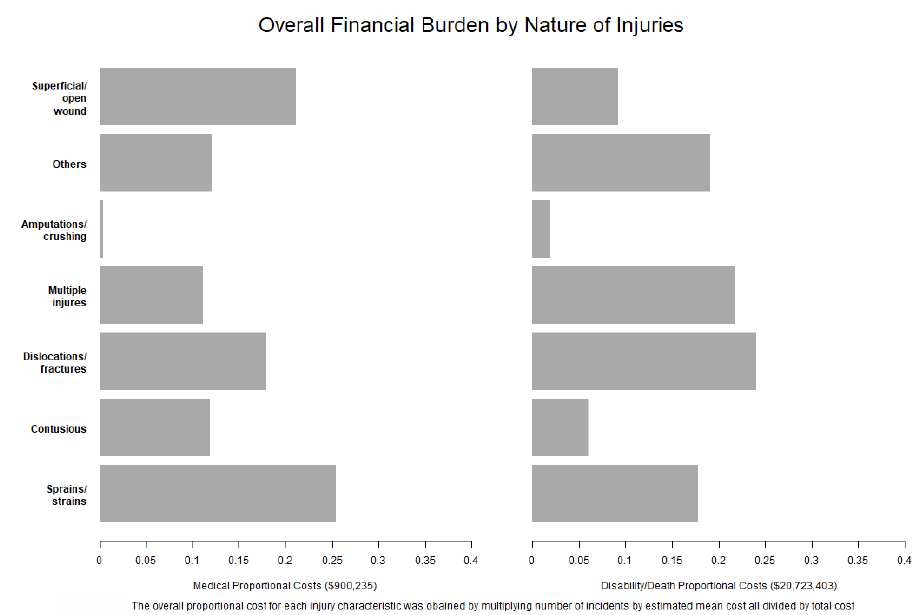
Figure 3. Overall financial burden by the nature of injury.